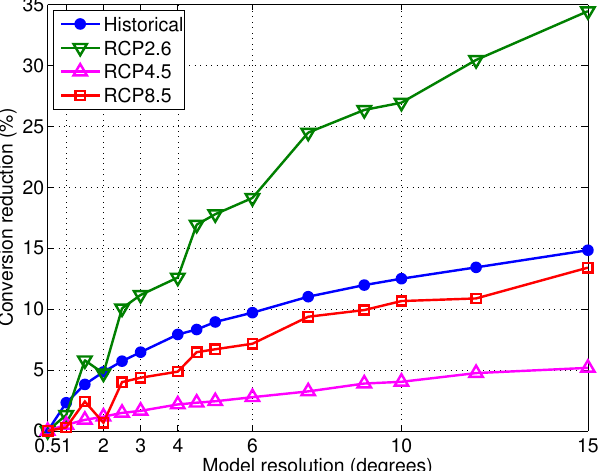
Figure A1. Relative reduction of area converted by net LULCC as function of resolution, using 0.5 ◦ as reference. Only resolutions with an integer number of cells around the globe have been calculated.